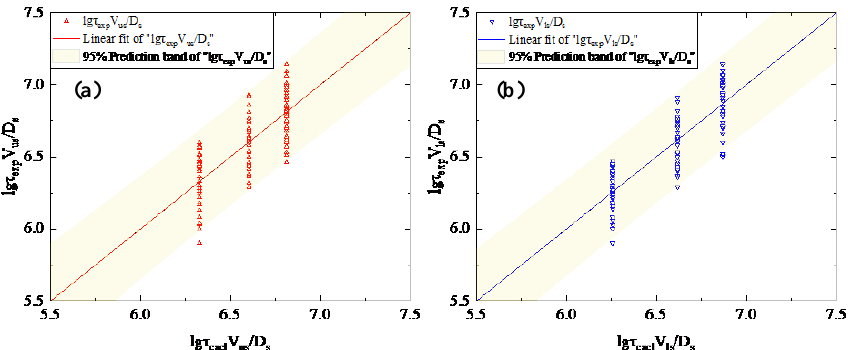
Figure 7. Comparison of experimental lg τ V s / D s with calculated ones for upper side nozzle ( a ) and lower side nozzle ( b ), respectively, using proposed Equations (17) and (18).